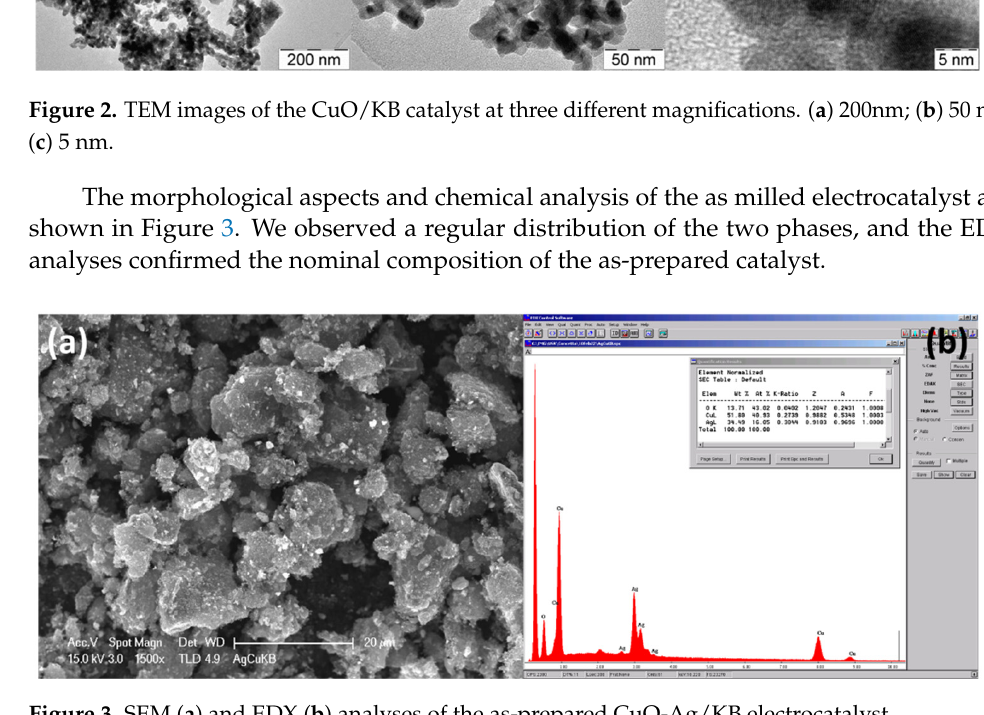
Figure 3. SEM ( a ) and EDX ( b ) analyses of the as-prepared CuO-Ag/KB electrocatalyst.